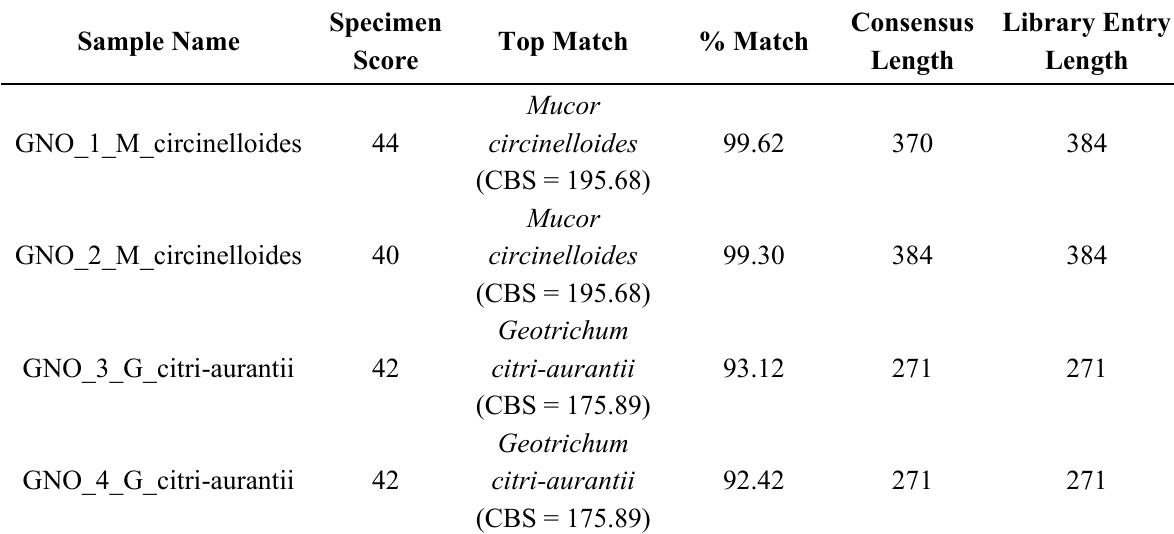
Table 4. Molecular identification of fungi isolated from municipal sewage sludge.